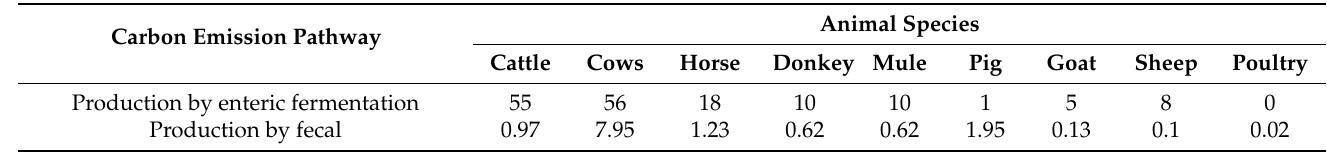
Table 2. The carbon emission coefficients of ruminant carbons from intestinal peristalsis and fecal (unit: kg/head ·